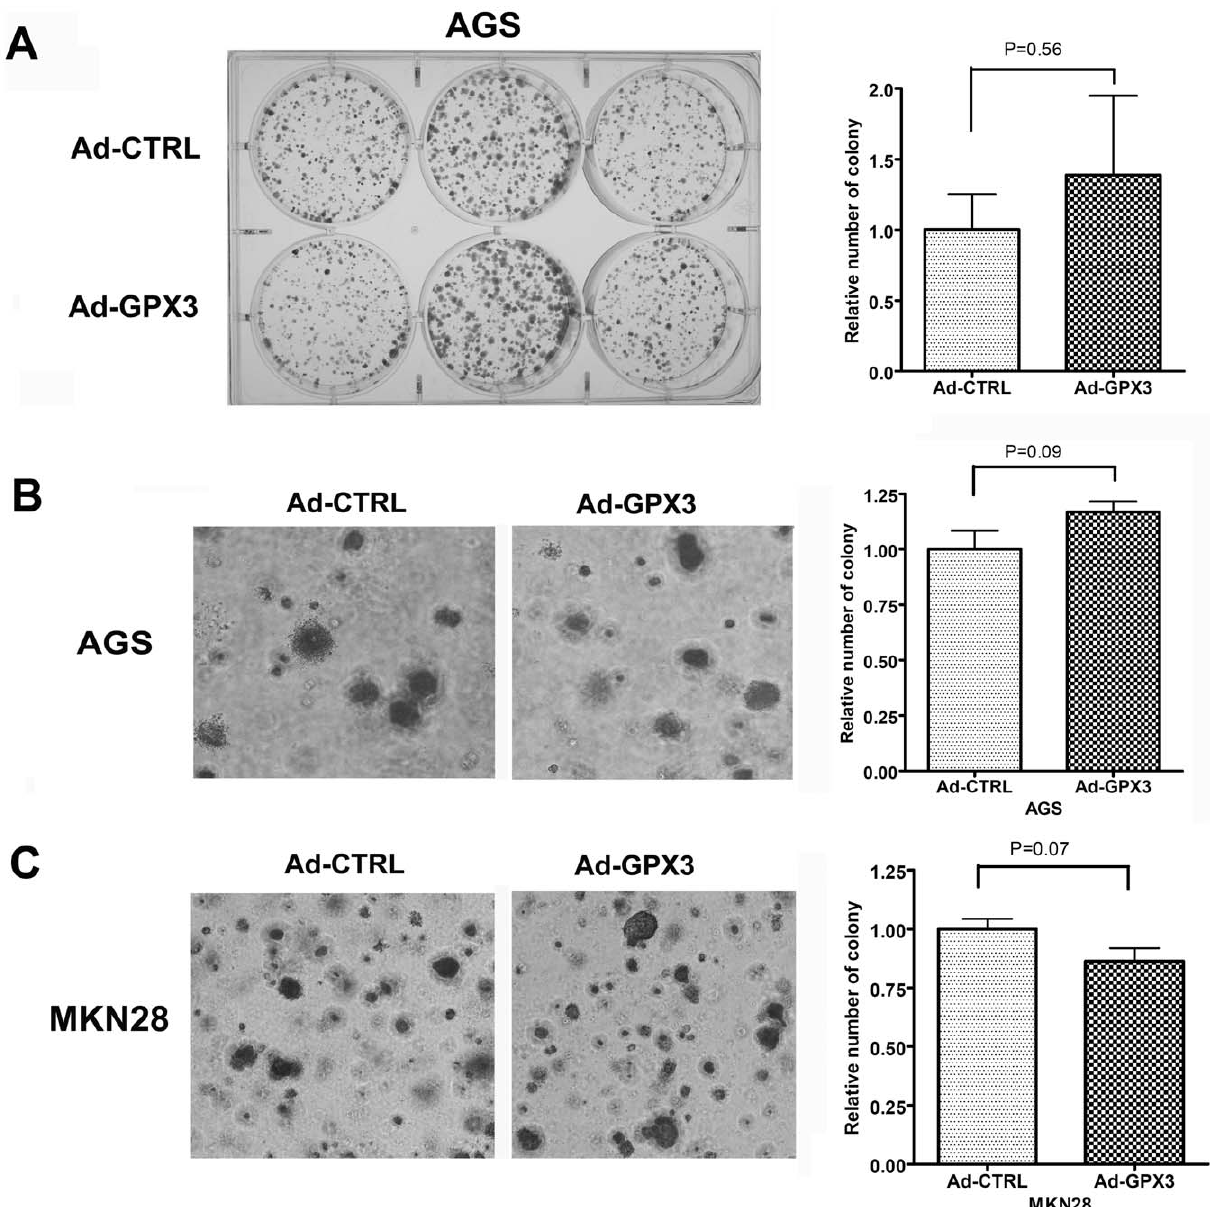
Figure 7. Reconstitution of GPX3 did not suppress tumor cells growth. (A) Colony formation assay in AGS cells. (B) Soft agar colony formation assay in AGS cells. (C) Soft agar colony formation assay in MKN28 cells. Right panels in A, B and C demonstrate the quantitative data using Image J software.